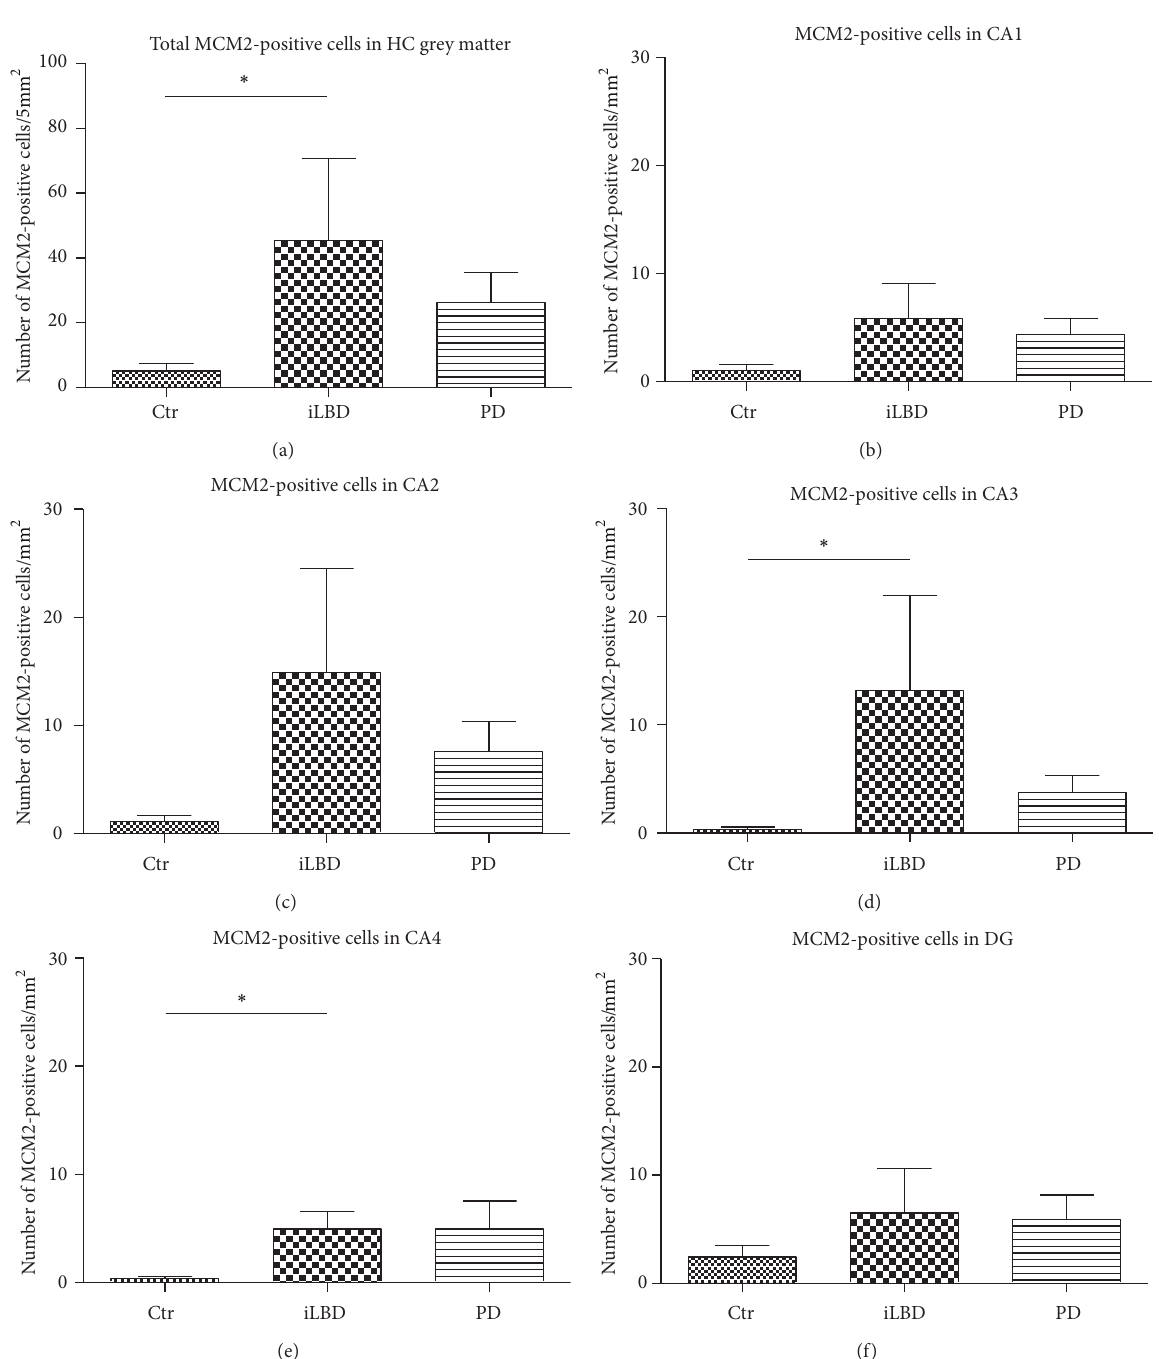
Figure 4: MCM2-positive cell numbers in the total HC and different hippocampal subregions. (a) The total number of MCM2-positive cells in the HC was significantly higher in iLBD cases compared to control subjects ( ∗ 𝑃 = 0.004 ; nonparametric Mann-Whitney 𝑈 test). (b–f) Comparing MCM2 IR per HC subregion between the 3 different groups revealed a significant increase in number of proliferating cells in hippocampal areas (d) CA3 and (e) CA4 (resp., ∗ 𝑃 = 0.001 , ∗ 𝑃 = 0.003 ; nonparametric Mann-Whitney 𝑈 test) of iLBD cases versus control subjects. Significance reached at alpha of 𝑃 ≤ 0.016 , Bonferroni-corrected. Data represent mean ± SEM